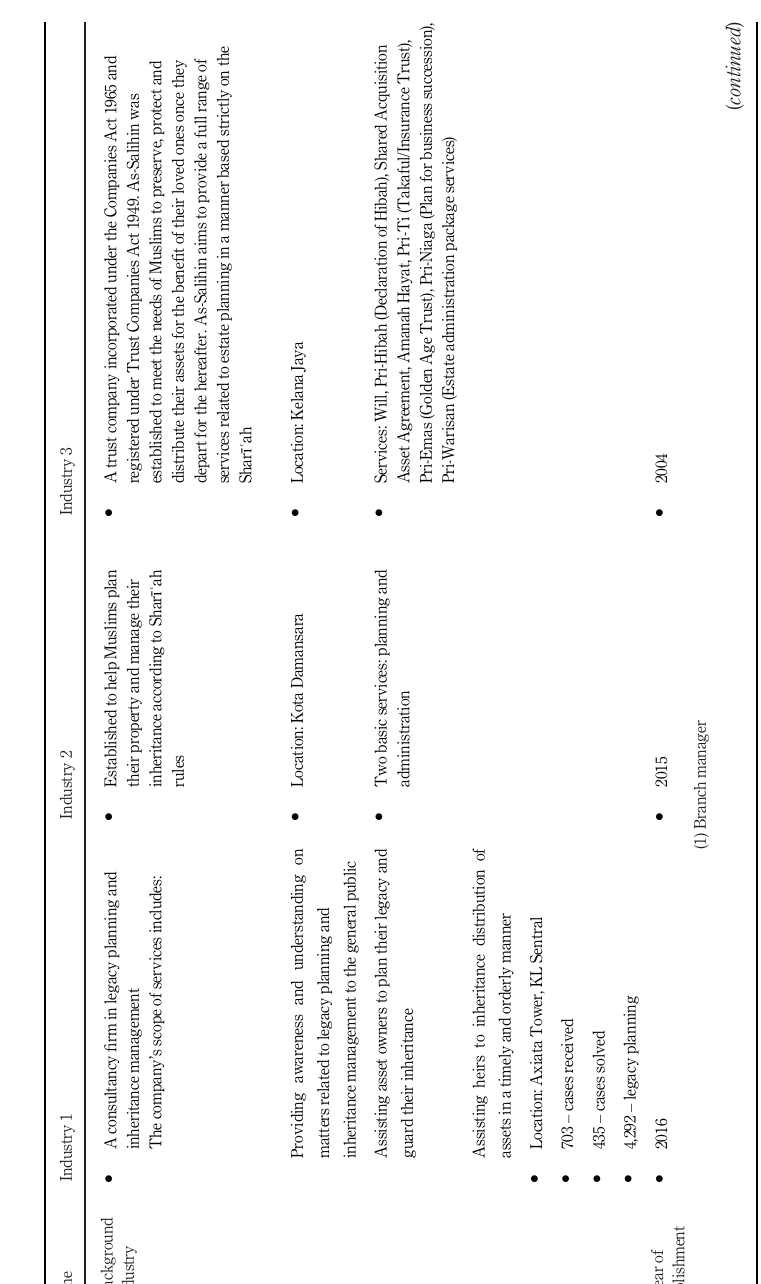
Table 2. Background of the industry